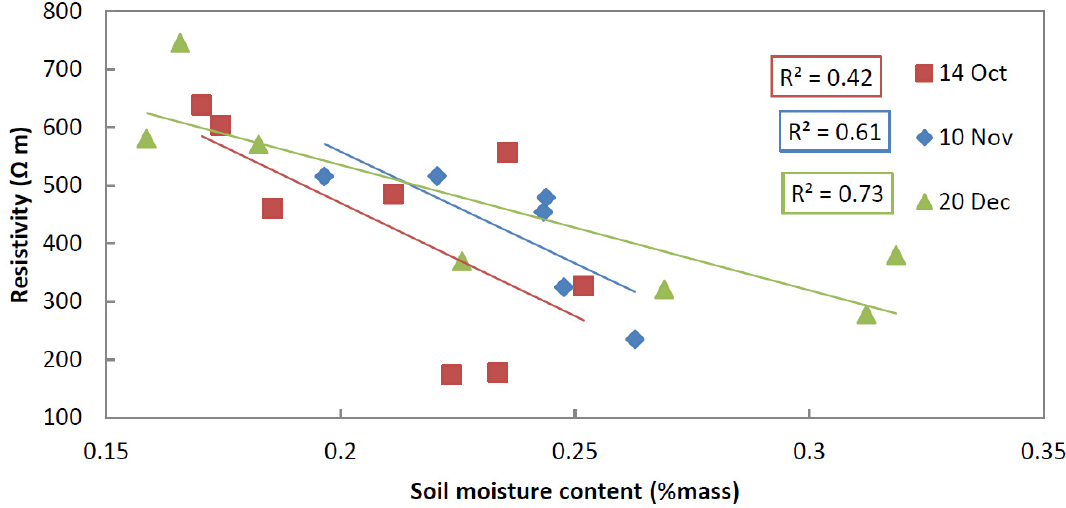
Figure 8. Correlation between soil moisture and resistivity at the depth of 90 cm indicated in Figure 5.